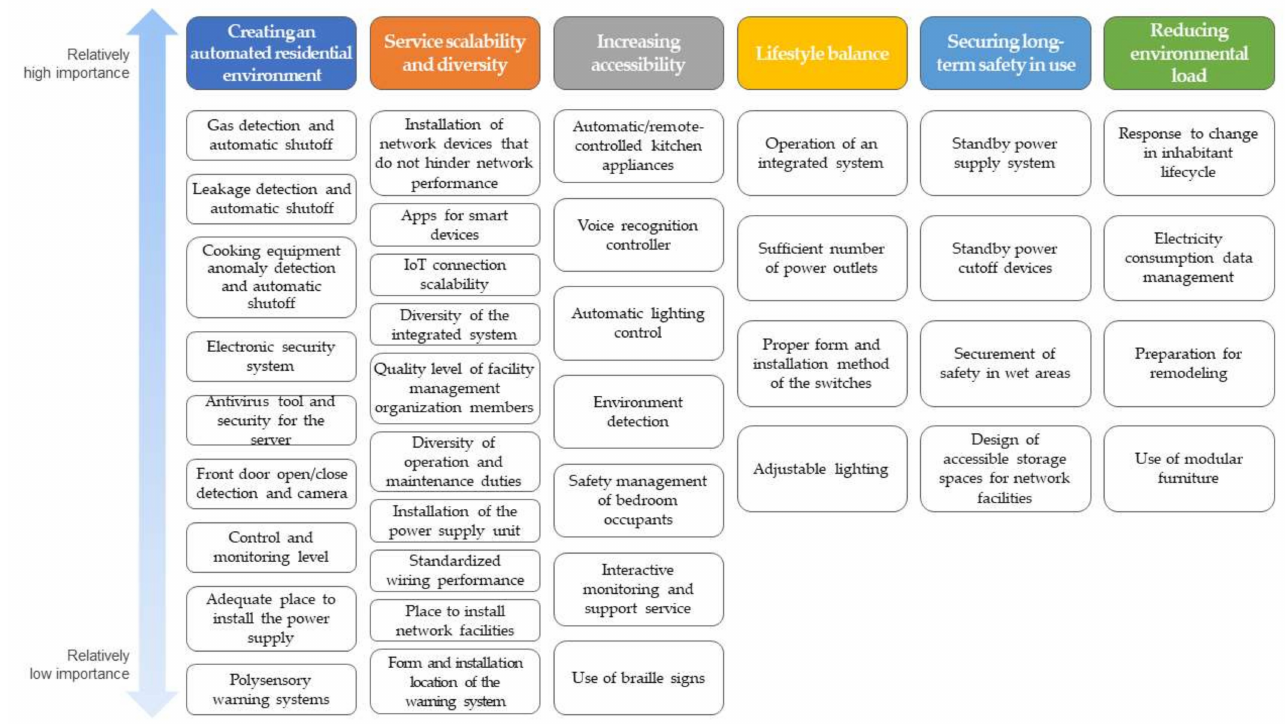
Figure 7. Relative importance of smart home design factors considering user